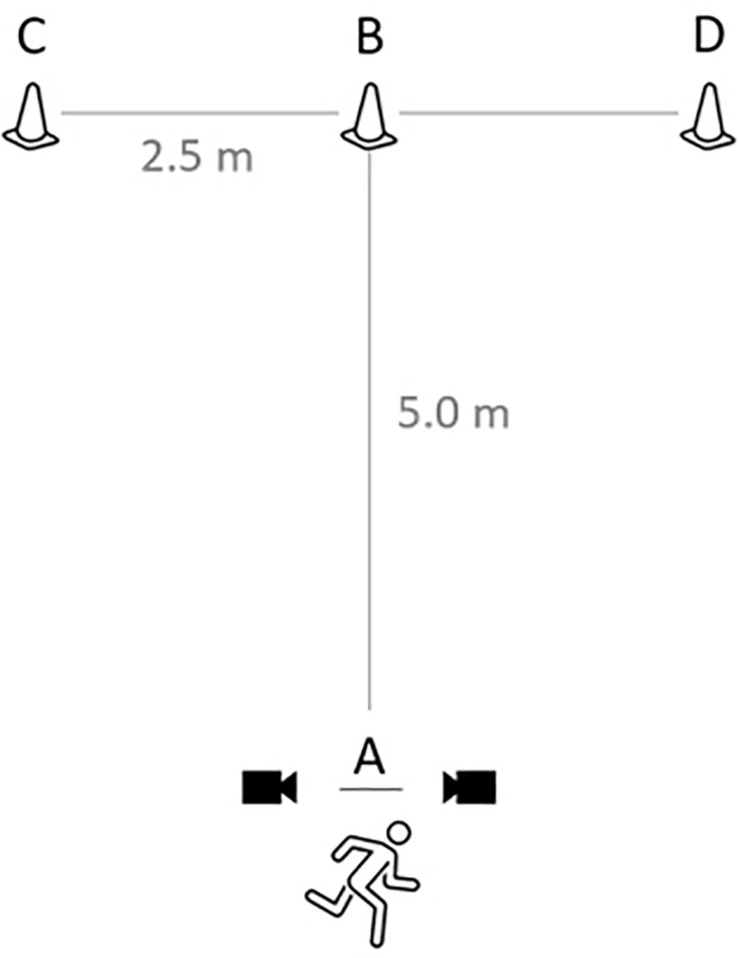
Schematic presentation of the t-half test modified by Sassi et al. (2009).